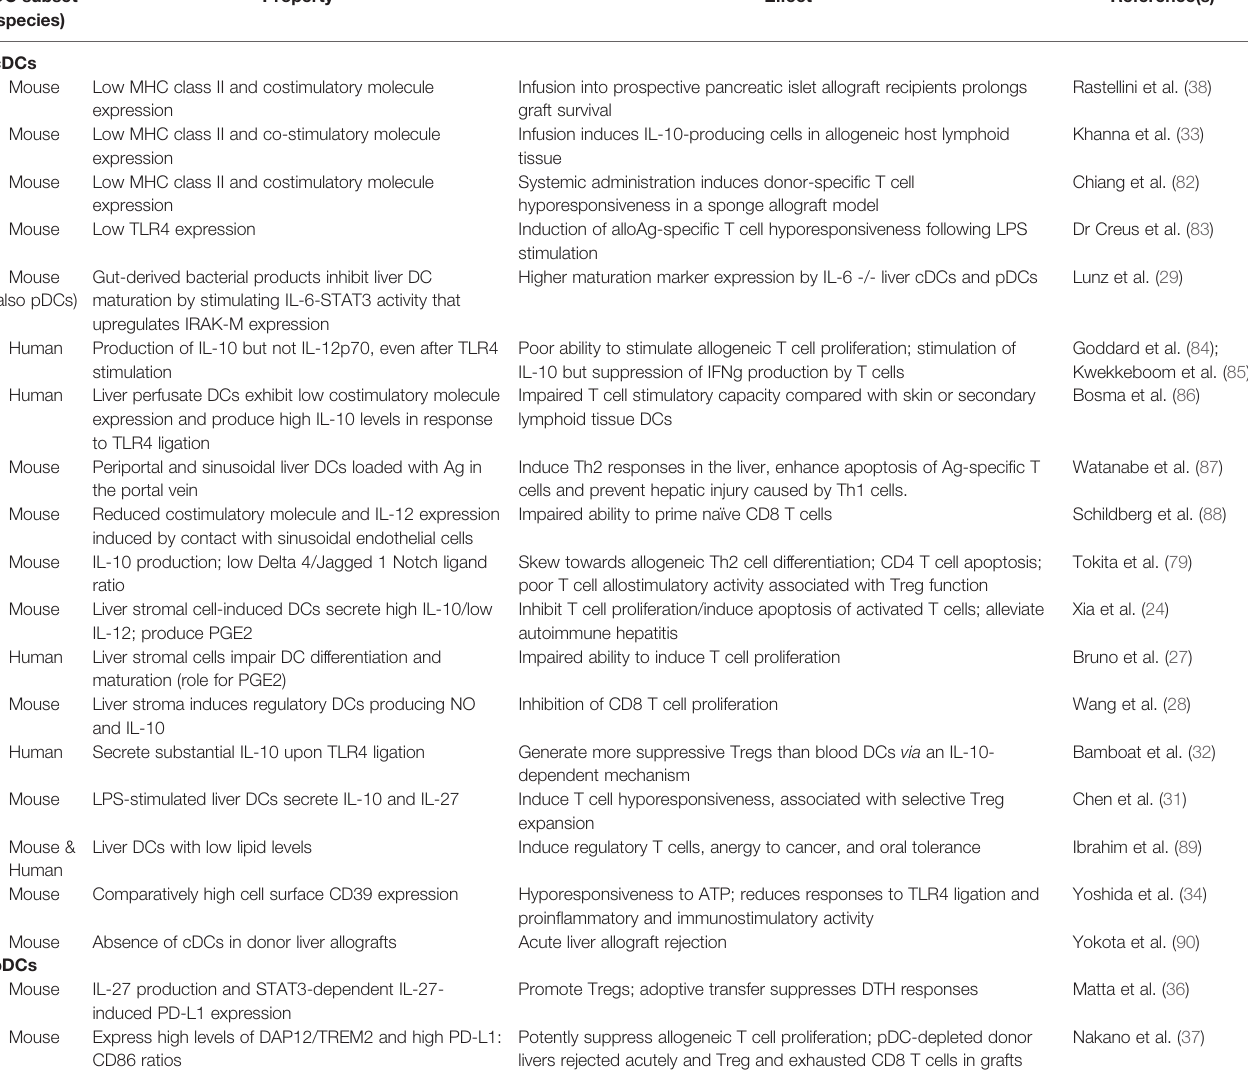
TABLE 2 | Properties of hepatic DCs that promote their immune regulatory function and may contribute to tolerance induction. DC subset